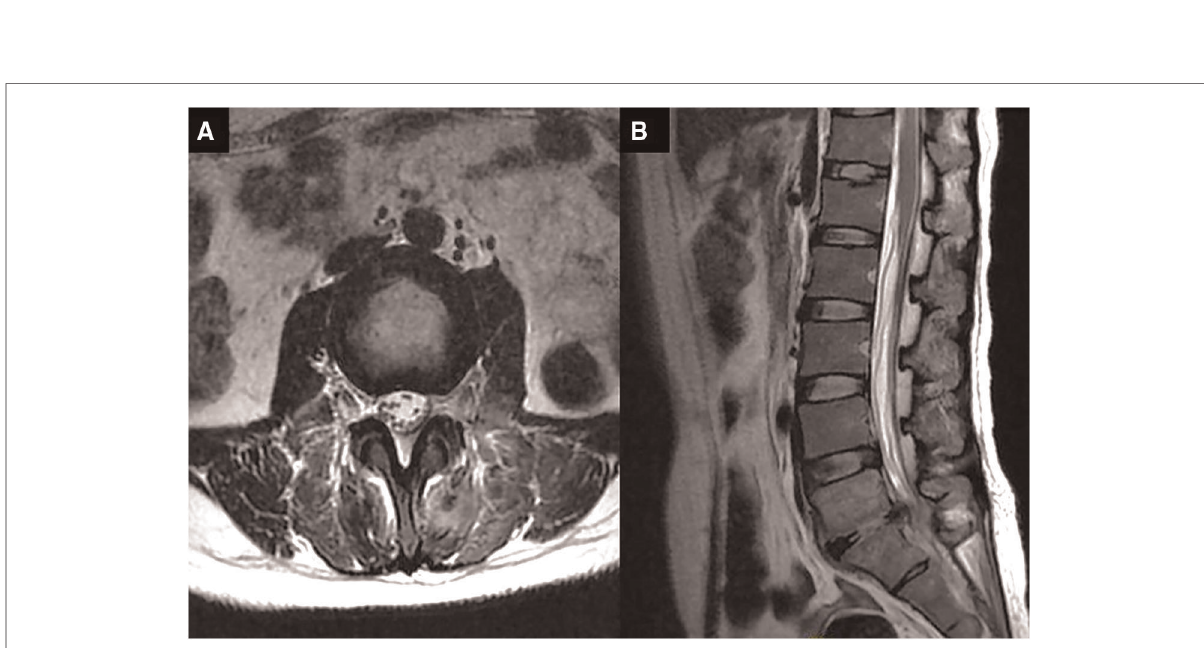
FIGURE 6 Magnetic resonance images of the lumbar vertebra after percutaneous endoscopic drainage for 1 month in axial ( A ) and sagittal ( B ). intraspinal and paravertebral abscesses have